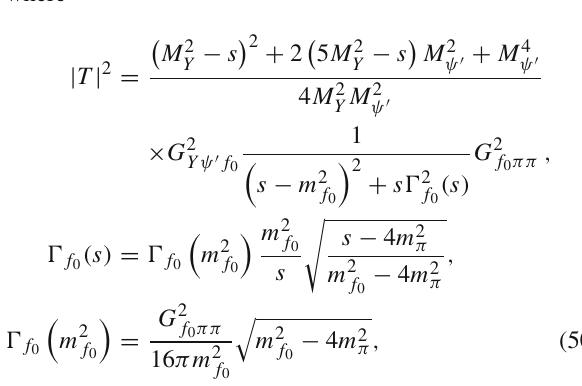
Fig. 2 The hadronic coupling constant G Y ψ (cid:4) f Borel parameter T 2 , the region between the two perpendicular lines is the Borel